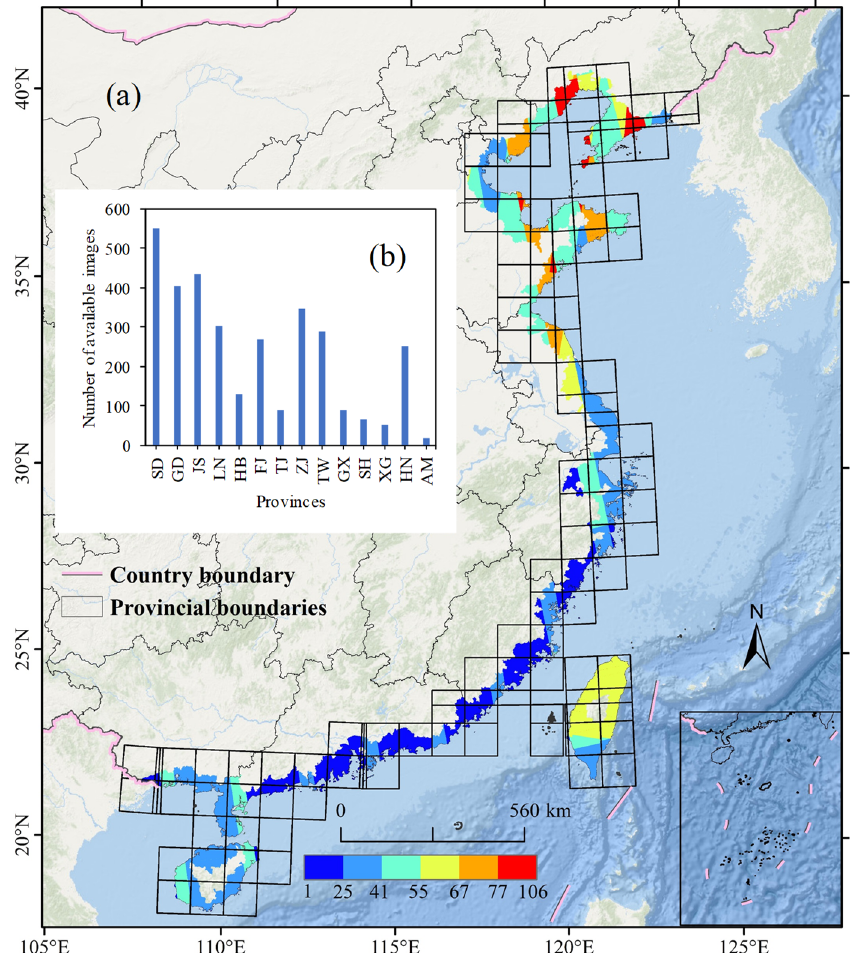
Figure 2. The number of available images in Sentinel ‐ 1 in the study area. (a) Availability of images in the entire study area; (b) number of available images in each province.